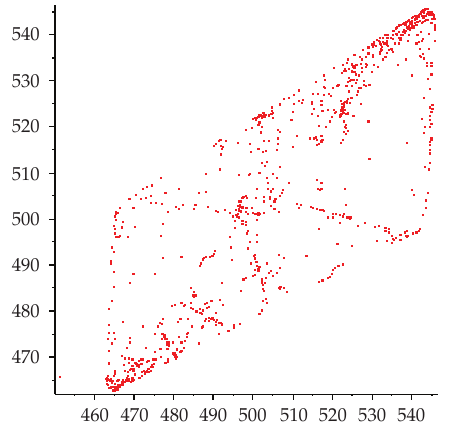
Figure 11: (cid:2) y (cid:2) t − 1 (cid:3) ,y (cid:2) t (cid:3)(cid:3) in the deterministic case for d (cid:7) 0 .